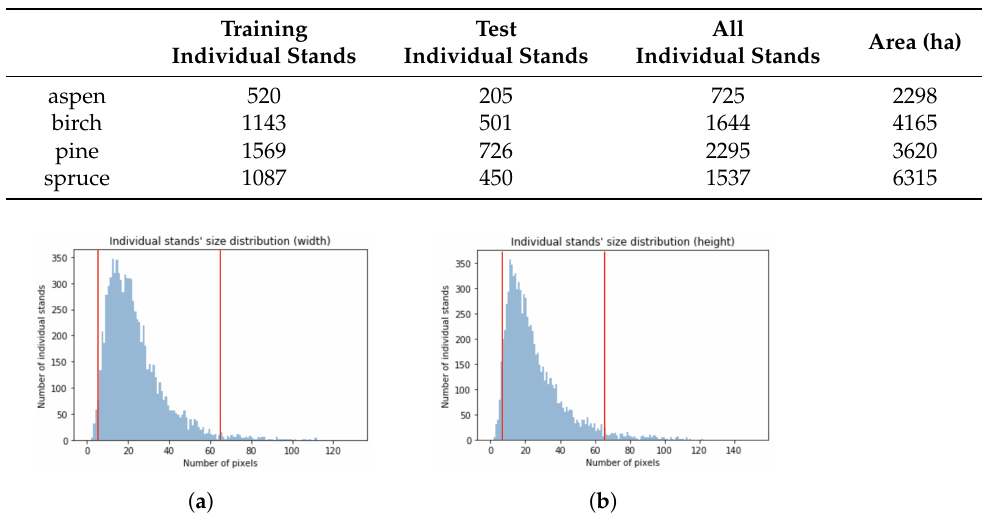
Figure 2. Size distribution of individual stands within the study area. Polygons with a side larger than 64 pixels or smaller than 8 pixels were eliminated.